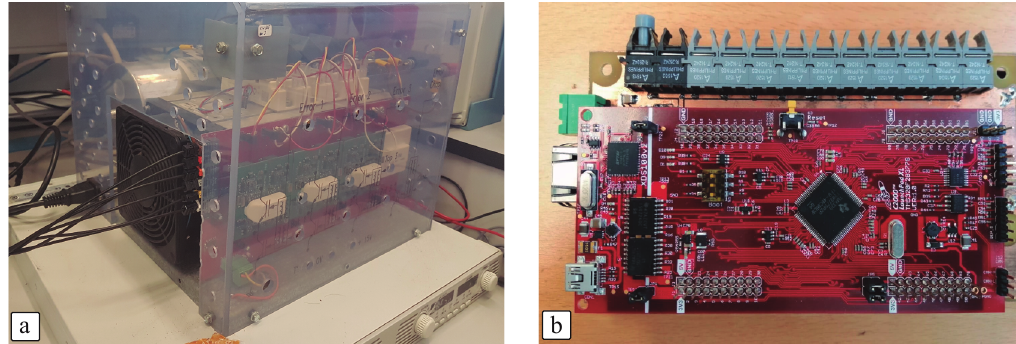
a b Figure 5. Experimental setup. ( a ) Three-phase power converter stack. ( b ) Digital control platform.